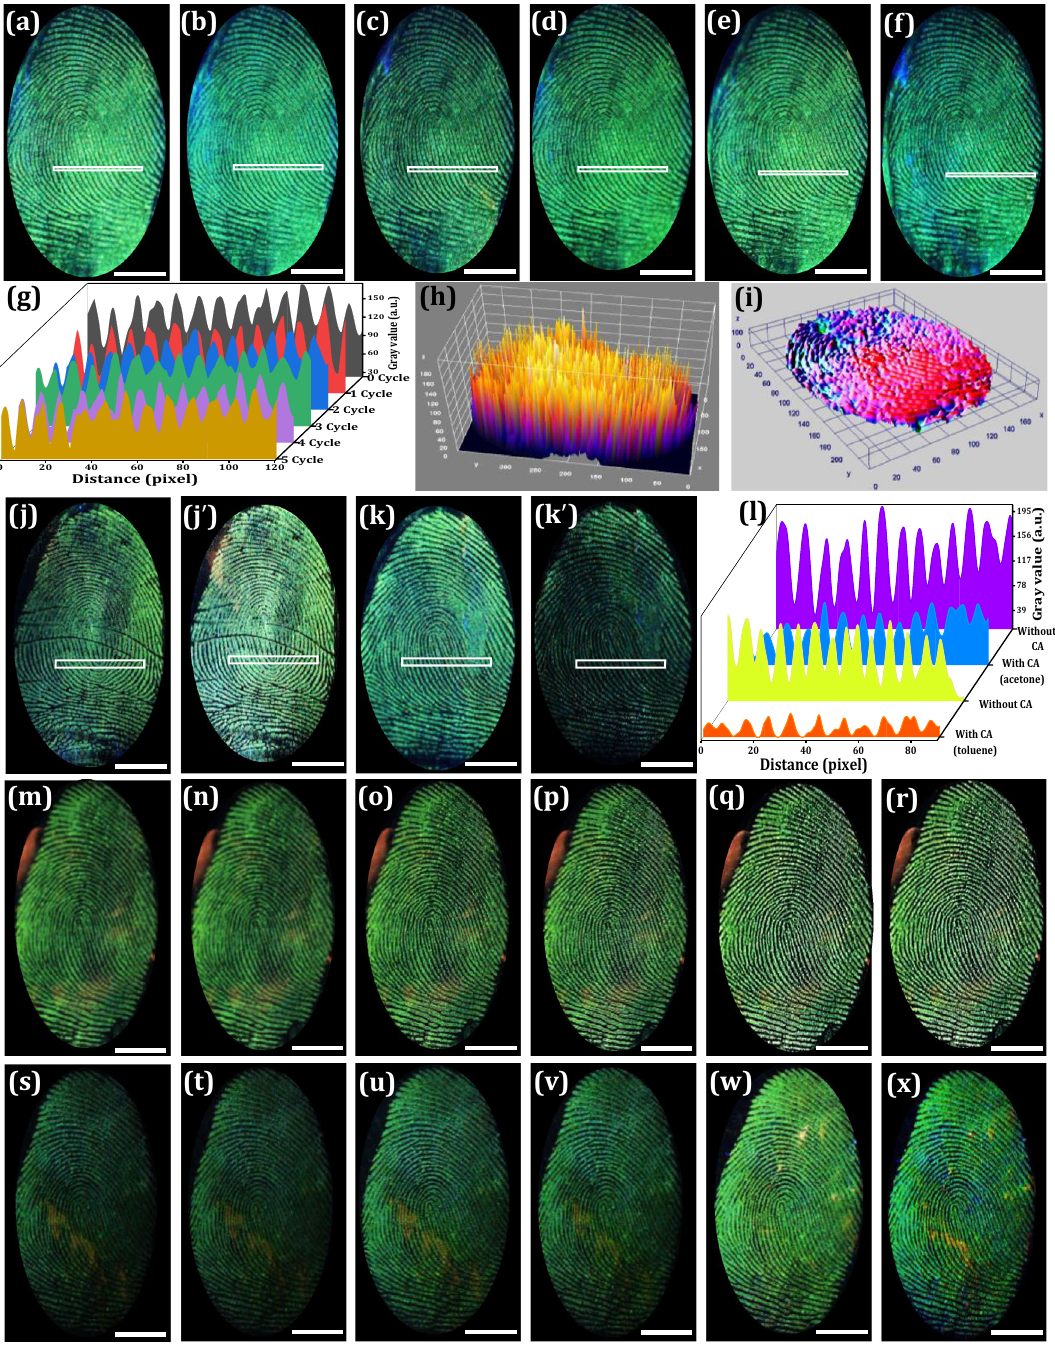
Figure 6. ( a – f ) Photographed images of the as developed and physically scraped FPs up to 5 cycles, which were visualized using LZOT:NH 4 Cl (4 wt. %) NPs under UV 254 nm light; ( g ) Gray scale pixel profiles in the white box region of the ( a – f ), showing distinct ridges and furrows due to excellence binding of the NPs over LFPs surface; ( h and i ) 3D interactive plots of the FPs before and after abrasion; RGB photographs of the visualized FPs under UV 254 nm light irradiation ( j and k ) before chemical treatment and ( j’ and k’ ) after abrasion; ( l ) Pixel profiles in the white box region of the ( j , j’ , k , k’ ); Photographed images of the FPs developed using optimized NPs on the glass surface followed by powder dusting technique under ( m – r ) UV 254 nm ( s – x ) UV 365 nm light irradiation with different time periods (0–5 h) (Scale bar: 5 mm). Figures ( h and i ) are generated using ImageJ software 1.8.0_172 (https:// imagej. nih. gov/ ij/ downl oad. html